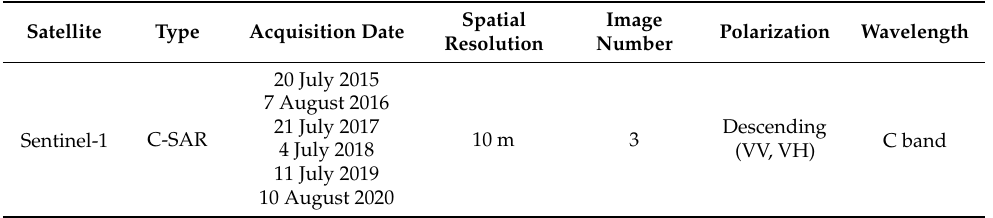
Table 1. Main specification of satellite imagery used in this